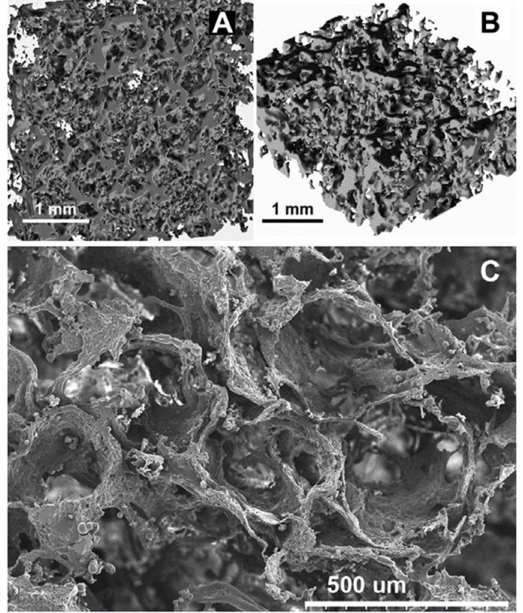
Figure 6. Polyurethane scaffolds. Micro-CT reconstructions: ( A ) top view, ( B ) 3-D view, ( C ) SEM image. Reprinted from [55] with permission from Elsevier.